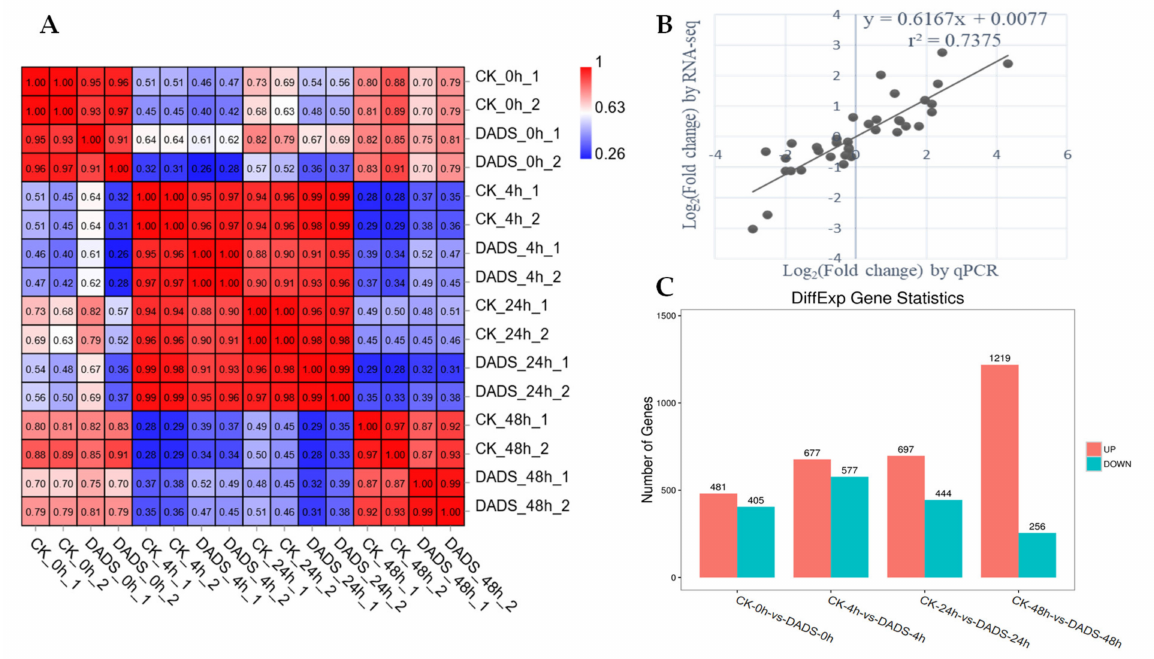
Figure 4. RNA − seq data and DEGs in DADS-treated and CK leaves with P . cubensis infection. ( A ) Pearson correlation of 16 samples based on the correlation coefficient ( r 2 ) between each sample. The color panel represents the r 2 values. ( B ) Correlation of expression changes observed by RNA − seq ( y − axis) and qPCR ( x − axis). ( C ) Number of up − and down − regulated DEGs for each sampled time point. Up and downregulated DEGs are displayed in red and green bars,